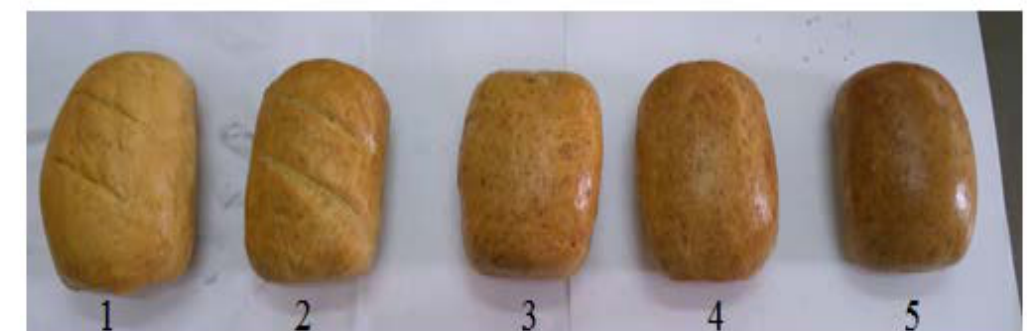
Figure 6. The impact of addition, in different concentrations, of Jerusalem artichoke flour on the color of the crust (degree of replacement of wheat flour with that of Jerusalem artichoke, %): 1 – control sample, 0%; 2 – 2,5 % 3- 5,0 %; 4 -7,5%; 5-